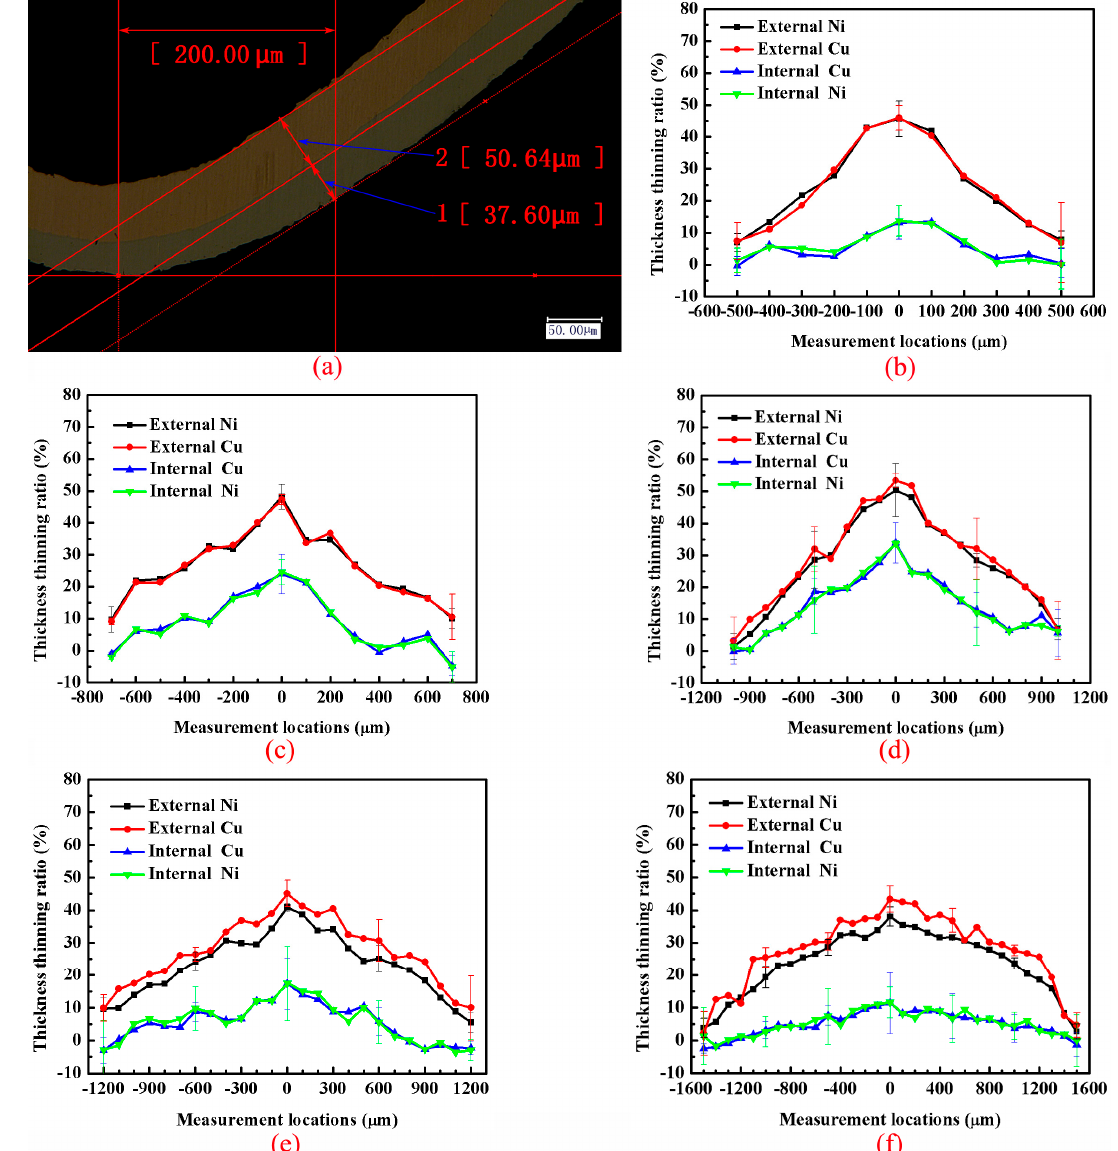
Figure 7. ( a ) Measurement method for thickness; Thickness thinning ratio of each layer: ( b ) mold 1; ( c ) mold 2; ( d ) mold 3; ( e ) mold 4; ( f ) mold 5.